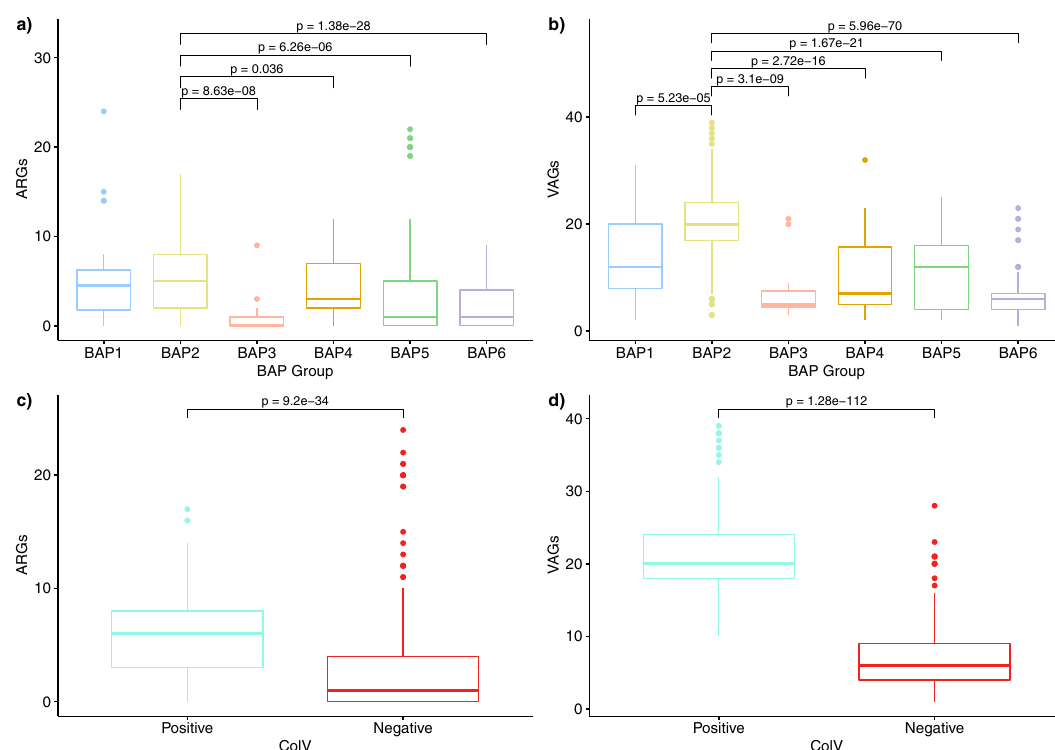
Fig. 7 Relationships of ARG and VAG carriage with BAP cluster and ColV carriage. Boxplots comparing total ARG and VAG counts by BAP clusters ( a, b; n = 750 biologically independent ST58 genome sequences) and ColV status for ( c, d; n = 752 biologically independent ST58 genome sequences). a ARG carriage by BAP cluster (Pairwise Wilcoxon test with Benjamini – Hochberg adjusted p -values); b VAG carriage by BAP cluster; (Pairwise Wilcoxon test with Benjamini – Hochberg adjusted p -values); c ARG carriage by ColV carriage (Two-sided Wilcoxon Rank-sum test); d VAG carriage by ColV carriage (Two- sided Wilcoxon Rank-sum test). Upper and lower limits of the boxes represent 75th and 25th quartile, centre line represents the median, whiskers extend to 1.5 × IQR and values outside these ranges are represented by dots. ARG maximum value is 24 and minimum value is 0. VAG maximum value is 39 and minimum value is 1. P -values for signi fi cant differences are shown. (n.b. Only signi fi cant differences between BAP2 and other groups are annotated with p - values in a and b